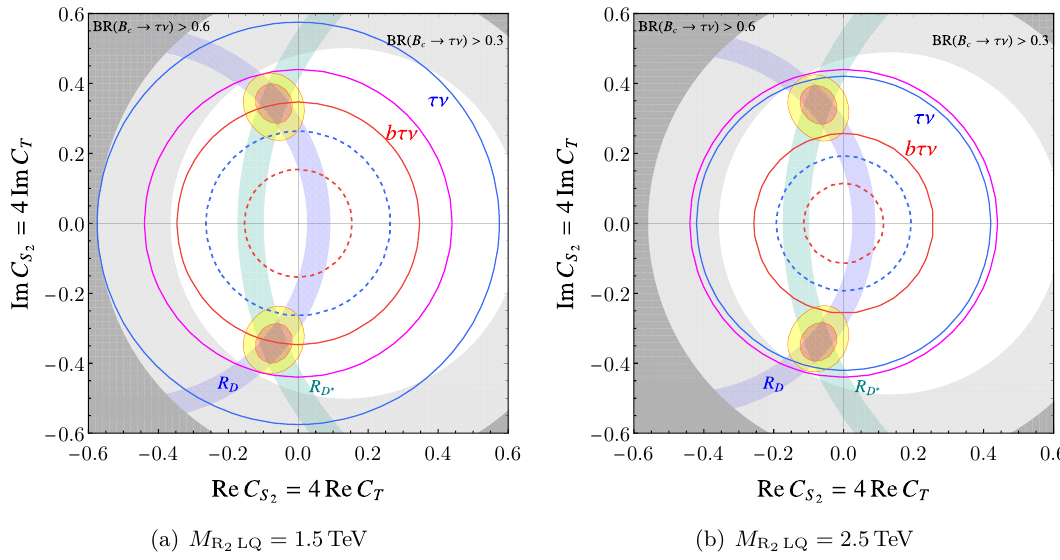
Figure 2 . The R 2 LQ scenario with M LQ = 1 . 5 and 2 . 5 TeV . The regions outside the blue and red lines are probed by the τ ± ν and τ ± ν + b searches, respectively, where the solid (dashed) lines R L dt correspond to = 139 fb − 1 ( 3000 fb − 1 ). The magenta line shows the current bound from the R L dt experimental data with = 36 fb − 1 [35]. The (lighter) gray shaded regions are constrained by BR ( B c → τν ) > 0 . 6 ( > 0 . 3 ). The R D and R D ∗ anomalies are explained at 1 σ in the blue and green shaded regions, respectively, while the combined fit at 1 / 2 σ is shown in